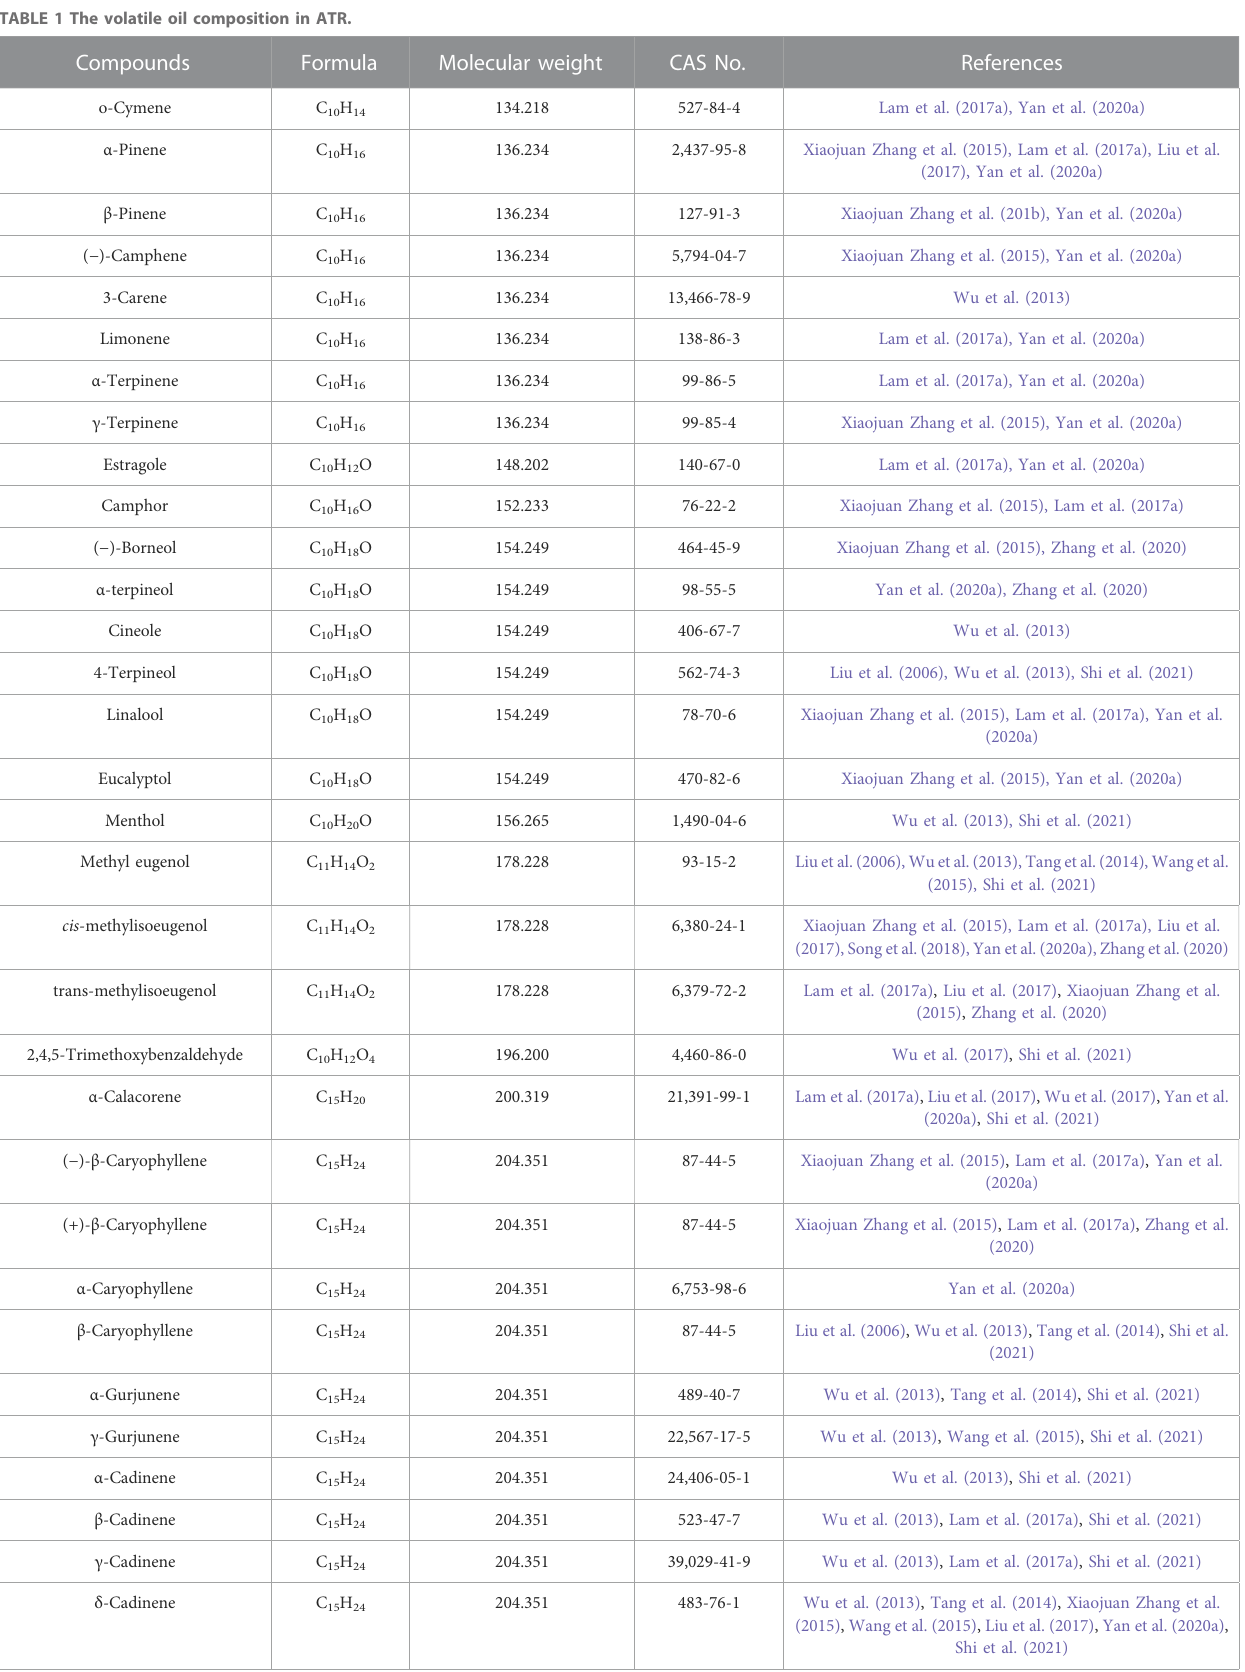
TABLE 1 The volatile oil composition in ATR.